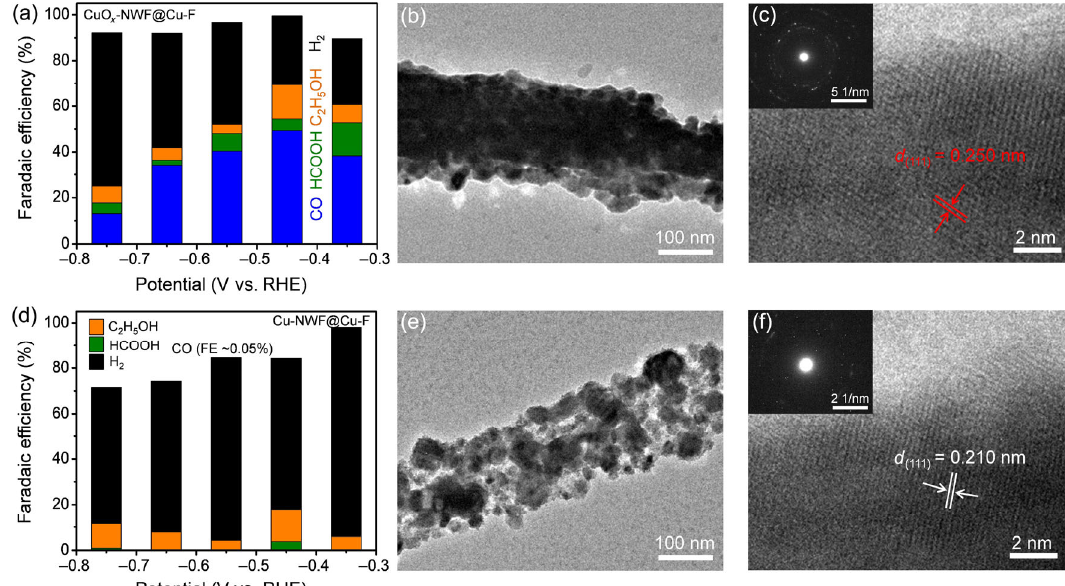
Figure 3 Electrocatalytic CO 2 performance of CuO x -NWF@Cu-F and Cu-NWF@Cu-F. (a) and (d) The applied potentials vs. the Faradaic efficiencies of major products for (a) CuO x -NWF@Cu-F and (d) Cu-NWF@Cu-F during electrocatalytic CO 2 reduction. (b) and (c) HRTEM images of CuO x -NWF@Cu-F (after electrolysis) with the lattice fringes assigned to the (111) planes of Cu 2 O. (e) and (f) HRTEM images of Cu-NWF@Cu-F with the lattice fringes assigned to the (111) facets of Cu. The corresponding SAED patterns in the inserts of (c) and (f) indicate the crystalline nature of CuO x -NWF@Cu-F and